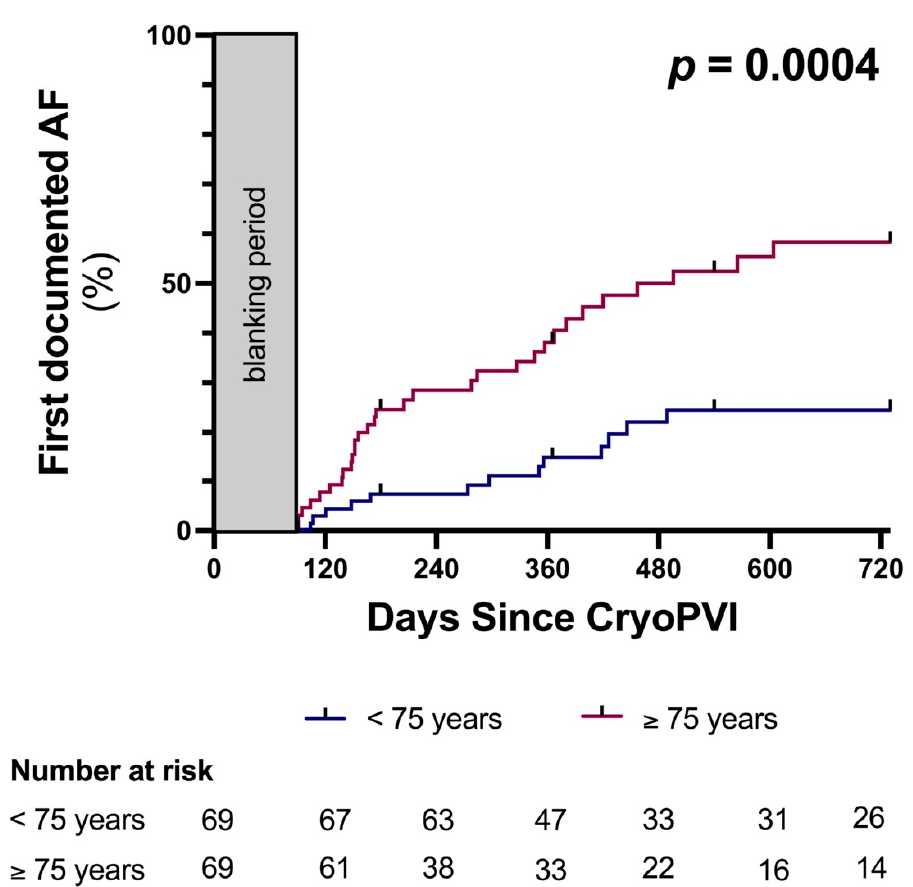
Figure 1. Kaplan-Maier estimates for patients aged over (purple) and under (blue) 75 years of age. AF, atrial fibrillation; cryoPVI, cryoballoon pulmonary vein isolation.